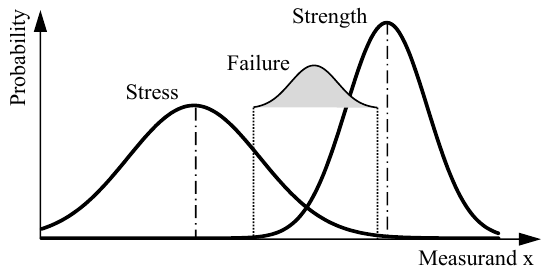
Figure 2: Stress-strength-interference Kopp (2013)